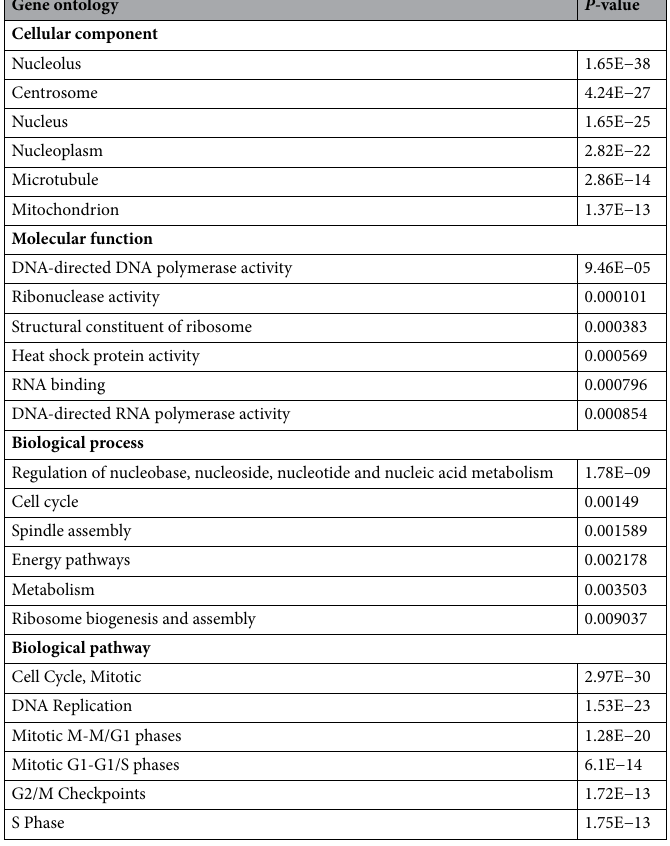
Table 6. Turquoise module functional enrichment results. www. kegg. jp/ kegg/ kegg1.